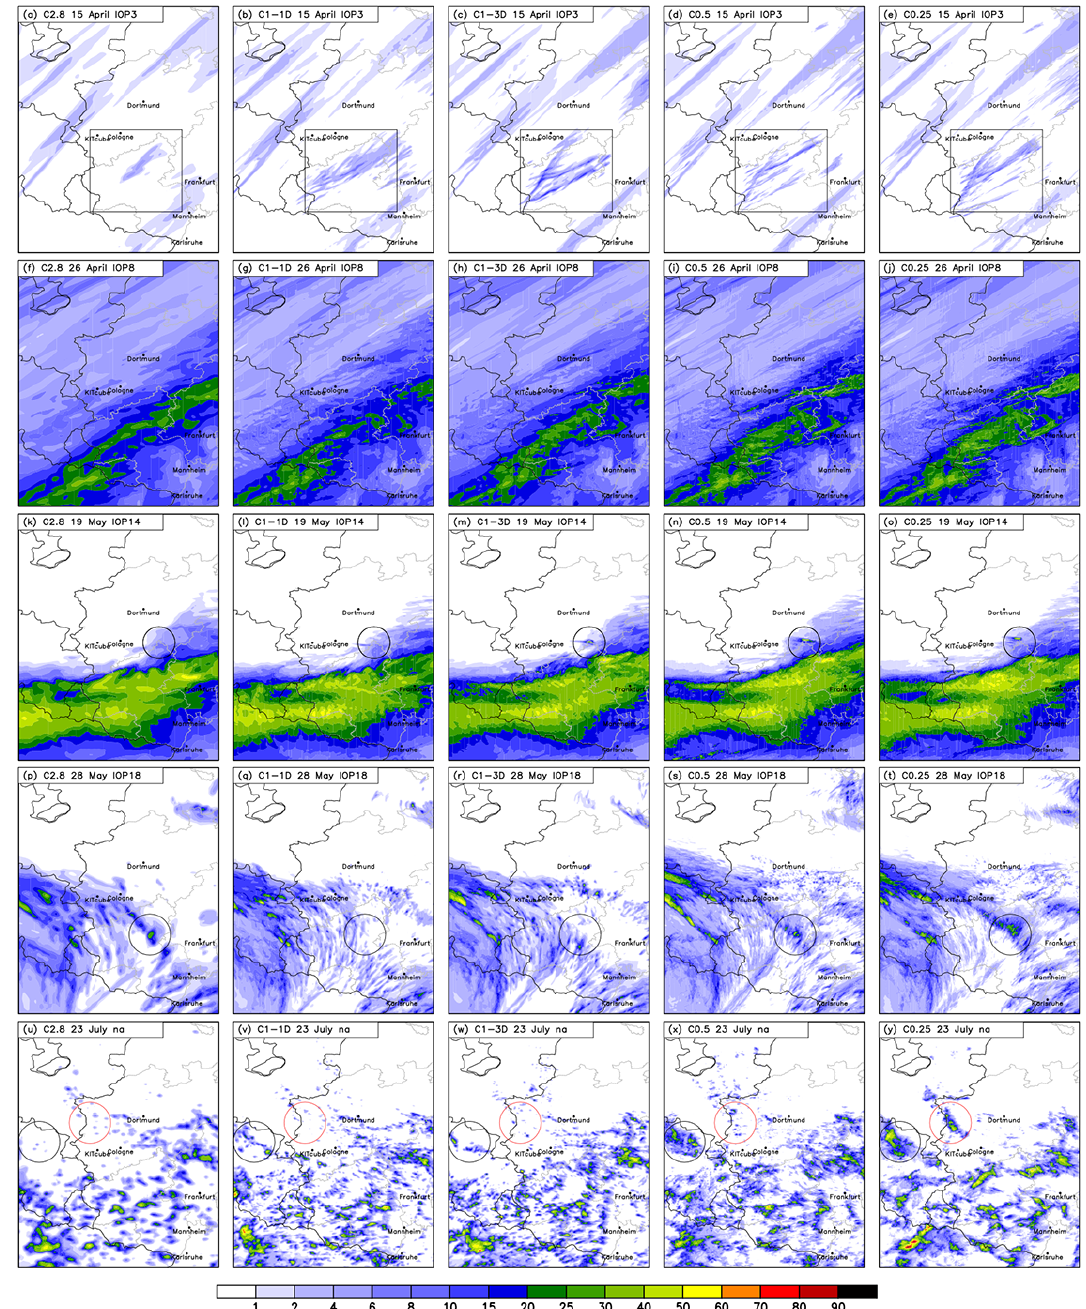
Figure 8. Simulated 24h accumulated precipitation in mm. Each row shows the results from 1 analyzed day for the different model runs. From top to bottom: 15, 26 April; 19, 28 May; 23 July